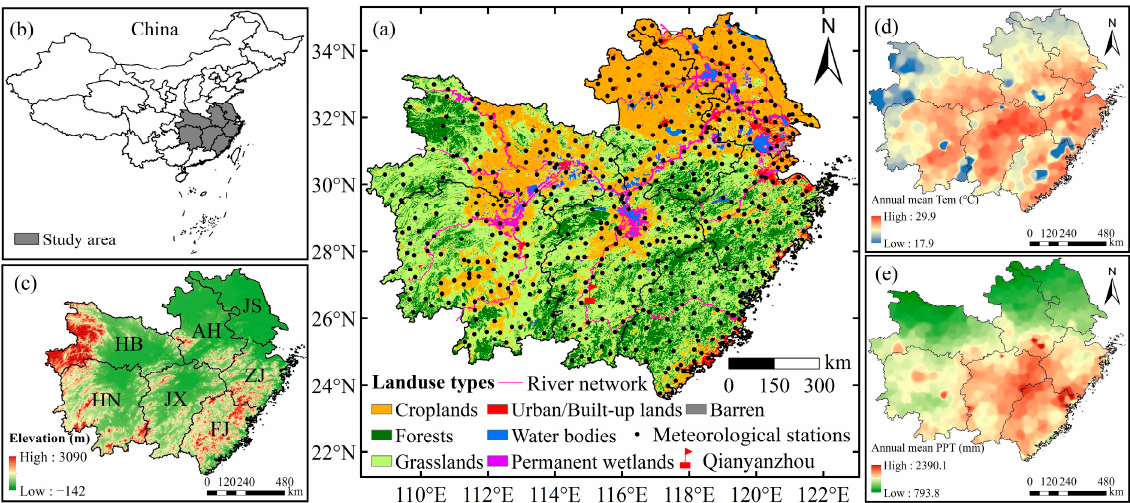
Figure 1. Land-use types and meteorological station distribution ( a ); location ( b ); elevation information ( c ); annual mean Tem ( d ) and PPT ( e ) during 2000–2020 of the study area. Note: HB, HN, JX, JS, AH, ZJ, and FJ are the abbreviations for Hubei, Hunan, Jiangxi, Jiangsu, Anhui, Zhejiang, and Fujian provinces, respectively.